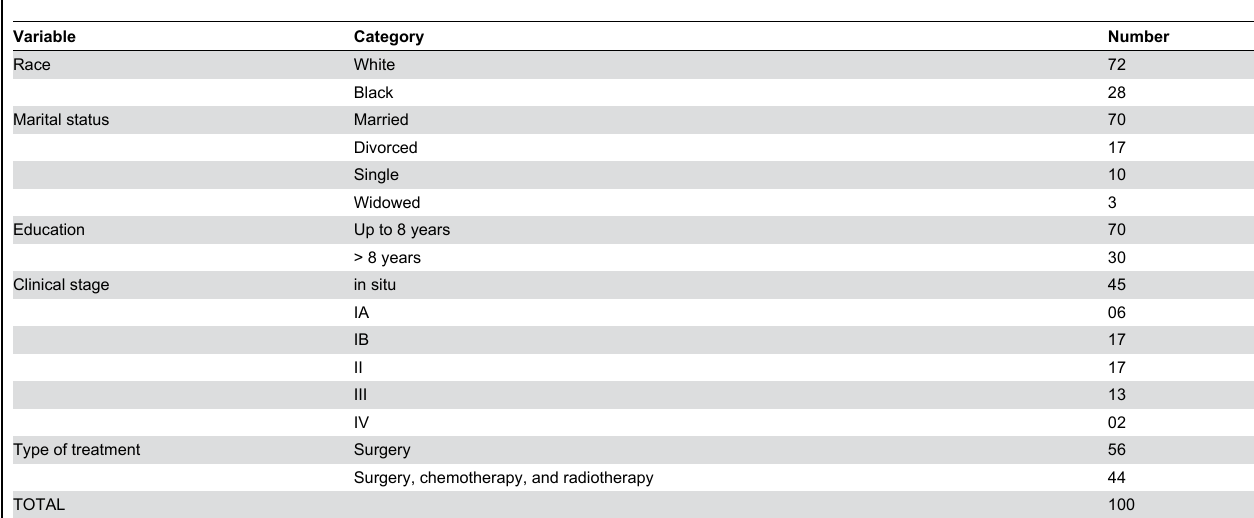
Table 1. Characteristics of the women sampled (n =